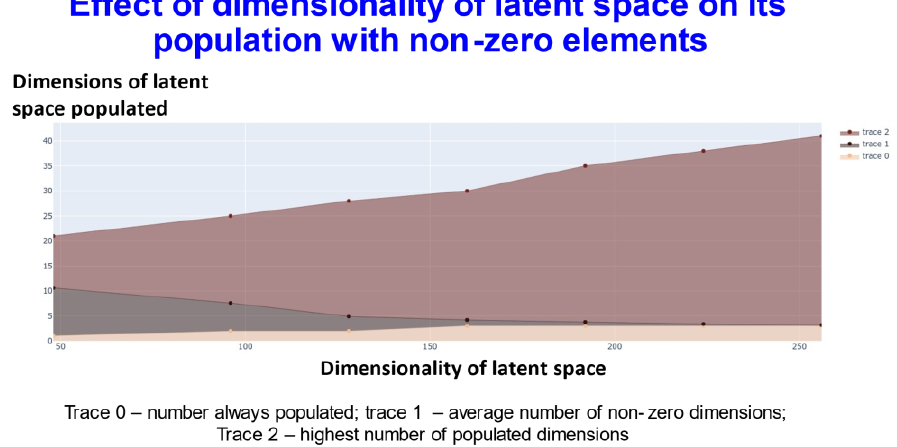
Figure 4. Relationship between the extent of population of different dimensions and the dimensionality of the latent space using transformers with contrastive learning.